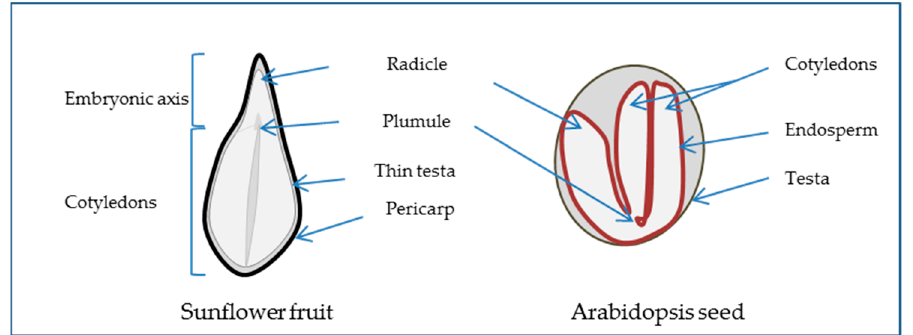
Figure 1. Seed morphology scheme presenting longitudinal section of sunflower fruit as a non-endospermic seed surrounded by the pericarp and Arabidopsis thaliana as an endospermic seed. Desiccation represents the last phase of seed development and corresponds to a huge loss of water content that decreases the seed water percentage in orthodox seeds to less than 10% of the dry weight (DW), depending on species (e.g., mature sunflower seeds contain 4% g H 2 O/g DW [1]). Such a low water content changes the cytoplasm from